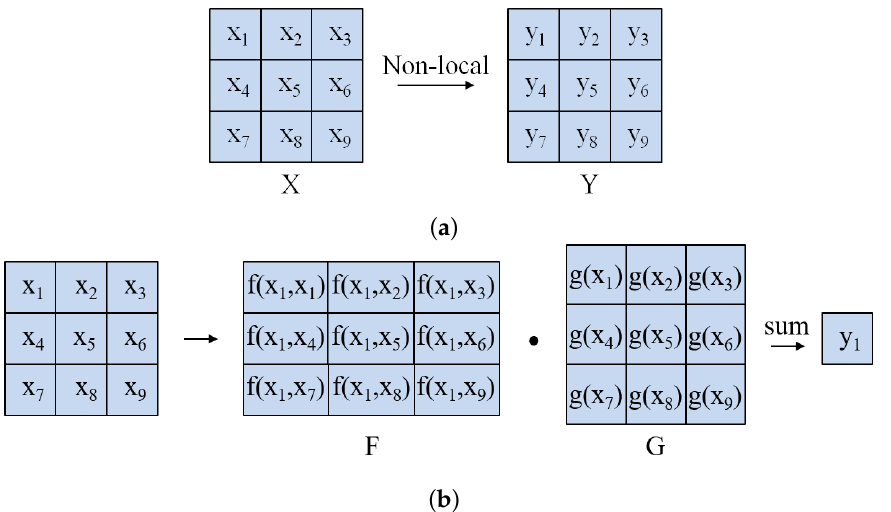
Figure 3. Non-local calculation in module. ( a ) The output matrix of feature map X through non-local module; ( b ) The calculation process of non-local module.